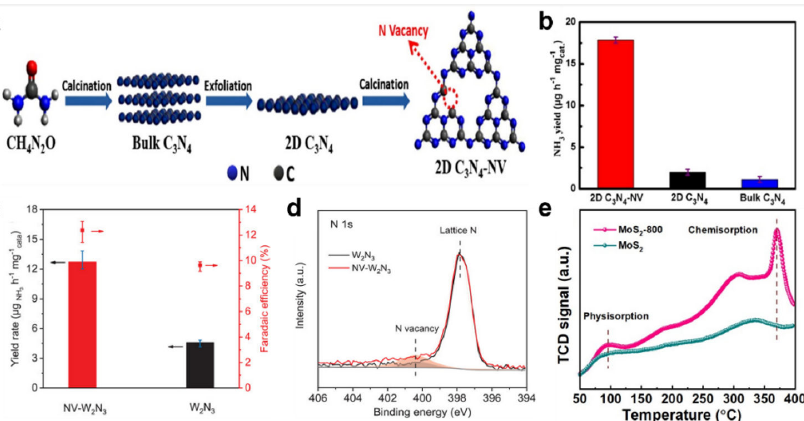
Figure 3. ( a ) Schematic diagram of 2D C 3 N 4 -NV synthetic route. ( b ) NH 3 production rates (NH 3 yield rates) of the 2D C 3 N 4 -NV, 2D C 3 N 4 , and bulk C 3 N 4 . Reproduced with permission [41]. Copyright 2021, Elsevier B.V. ( c ) NH 3 yield of NV-W 2 N 3 and W 2 N 3 at − 0.2 V RHE . ( d ) Synchrotron-based